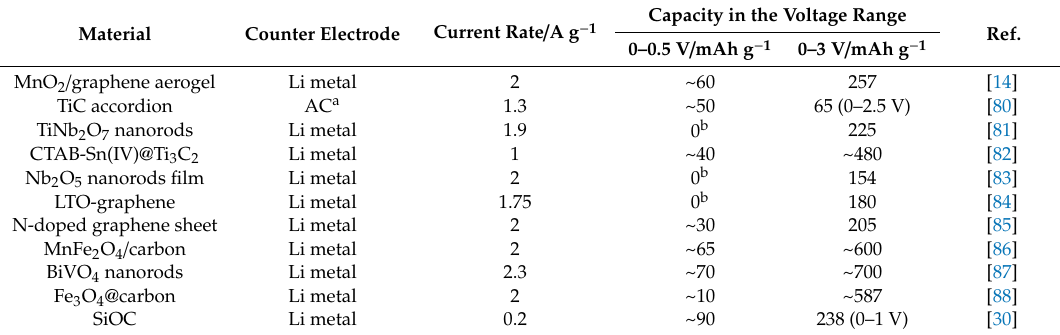
Table 5. Capacity recovered below 0.5 V at high current rates for LIC anodic materials.